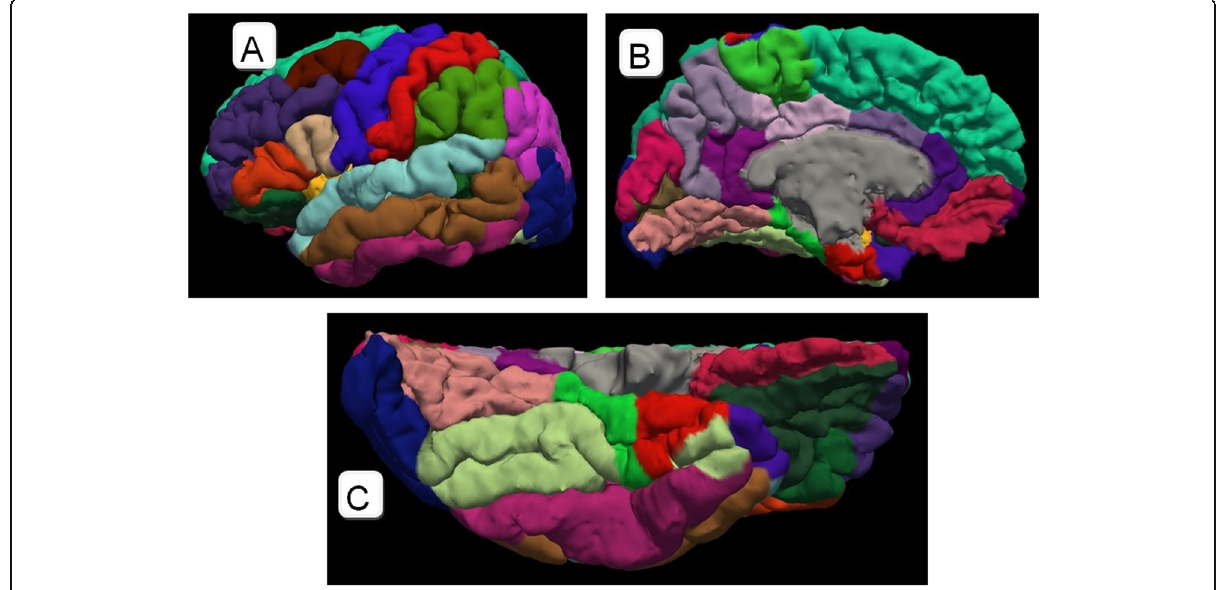
Fig. 1 Brain segmentation . a Lateral view. b Medial view. c Inferior